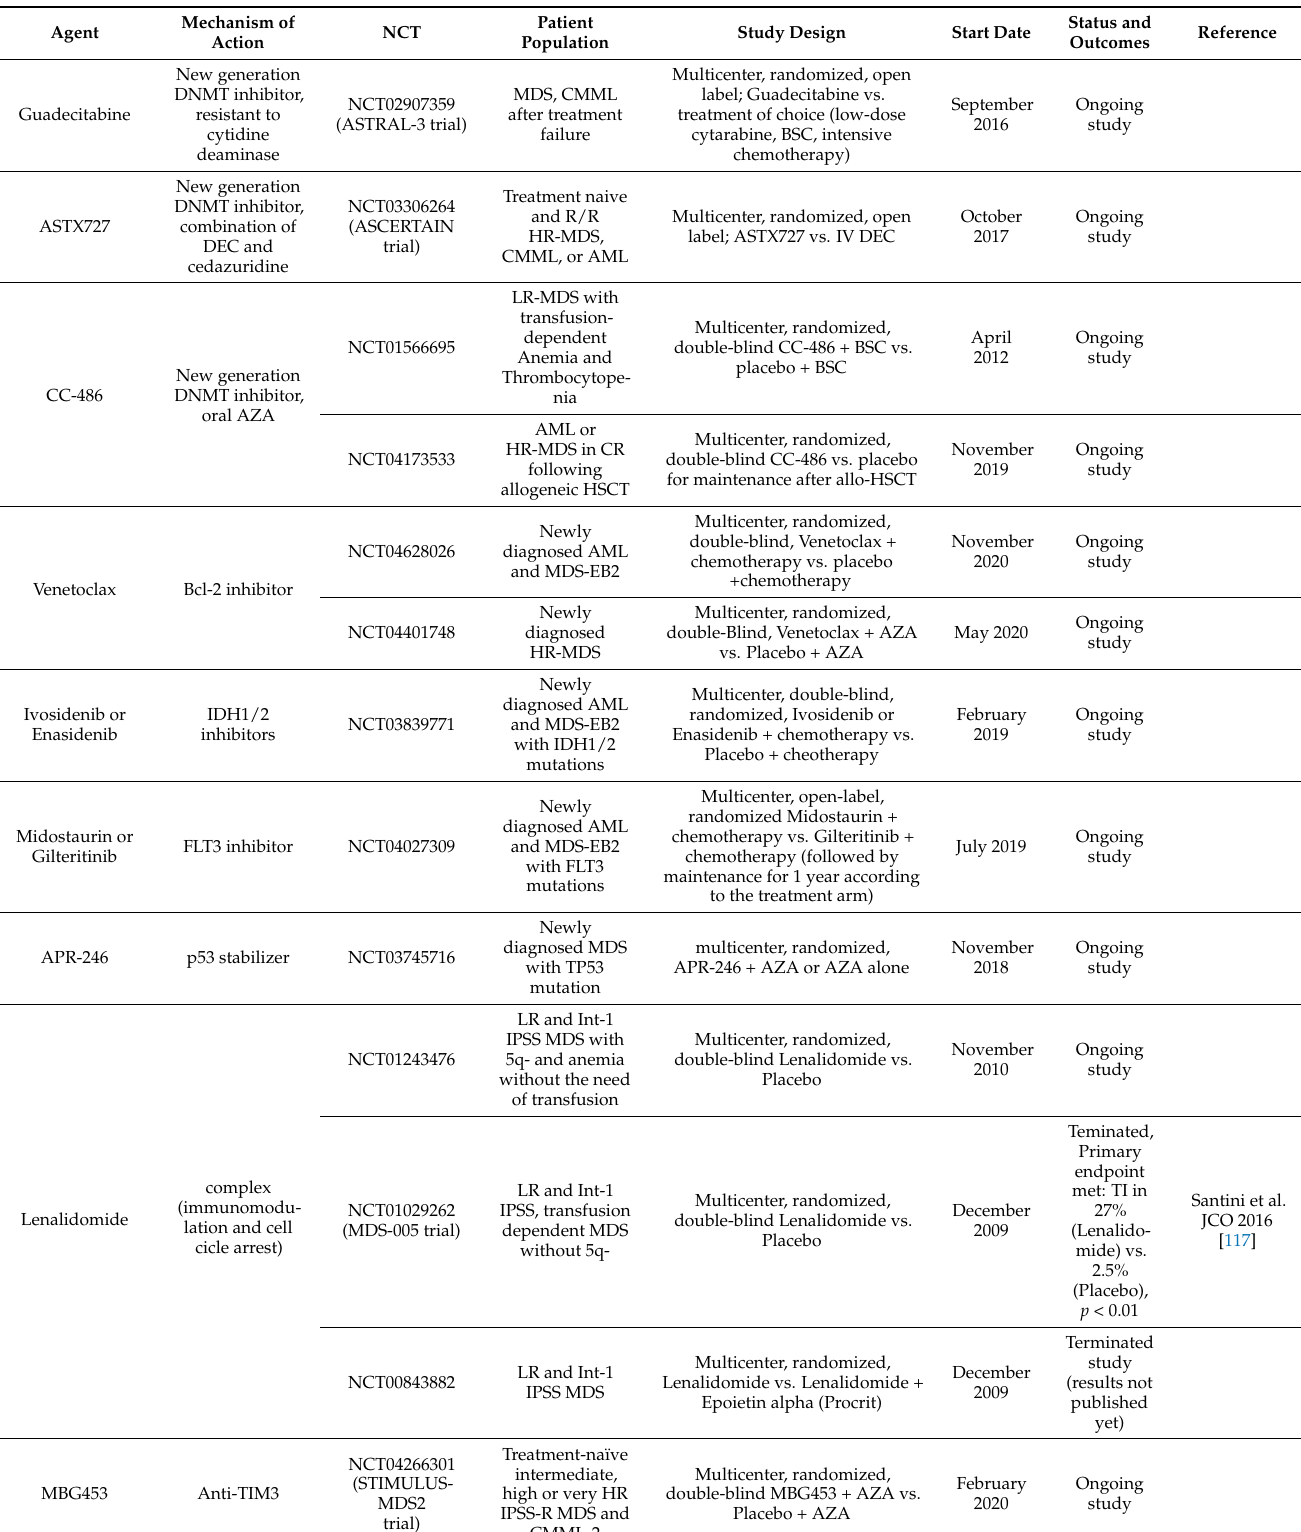
Table 2. Selected phase III studies for investigational agents in MDS